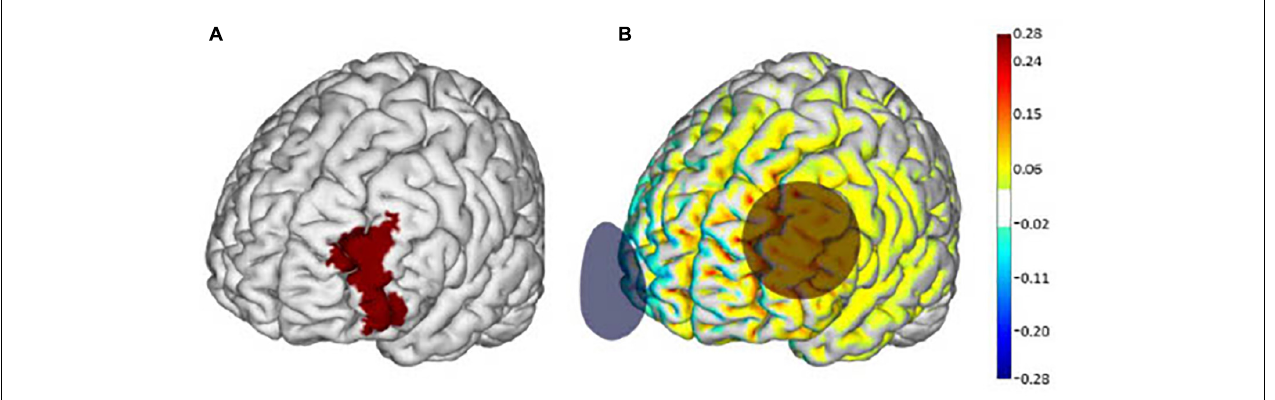
FIGURE 1 | Transcranial direct current stimulation (tDCS) electrode placement and modeling of electrical current flow. (A) The left dorsolateral prefrontal cortex (dlPFC) (Brodmann Area 46) is highlighted in red. (B) Active tDCS was delivered at a maximum intensity of 2.0 mA with the anode (red circle) placed over the F3 regions and the cathode (blue circle) over the Fp2 region according to the 10–20 EEG placement system. Warmer and cooler colors depict the normal component of the electrical field produced by this stimulation, modeled on a standard brain as described in Miranda (2013). Images adapted from Manor et al. (2018) with permission from